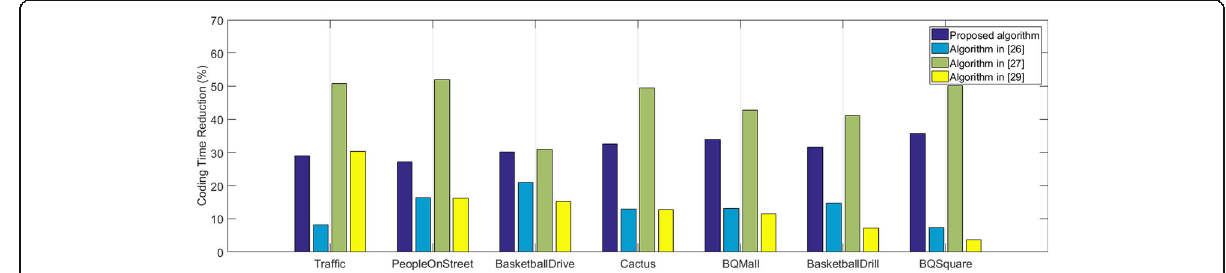
Fig. 11 Coding time reduction comparison of the proposed algorithm and the algorithms in [26, 27, 29] in RA